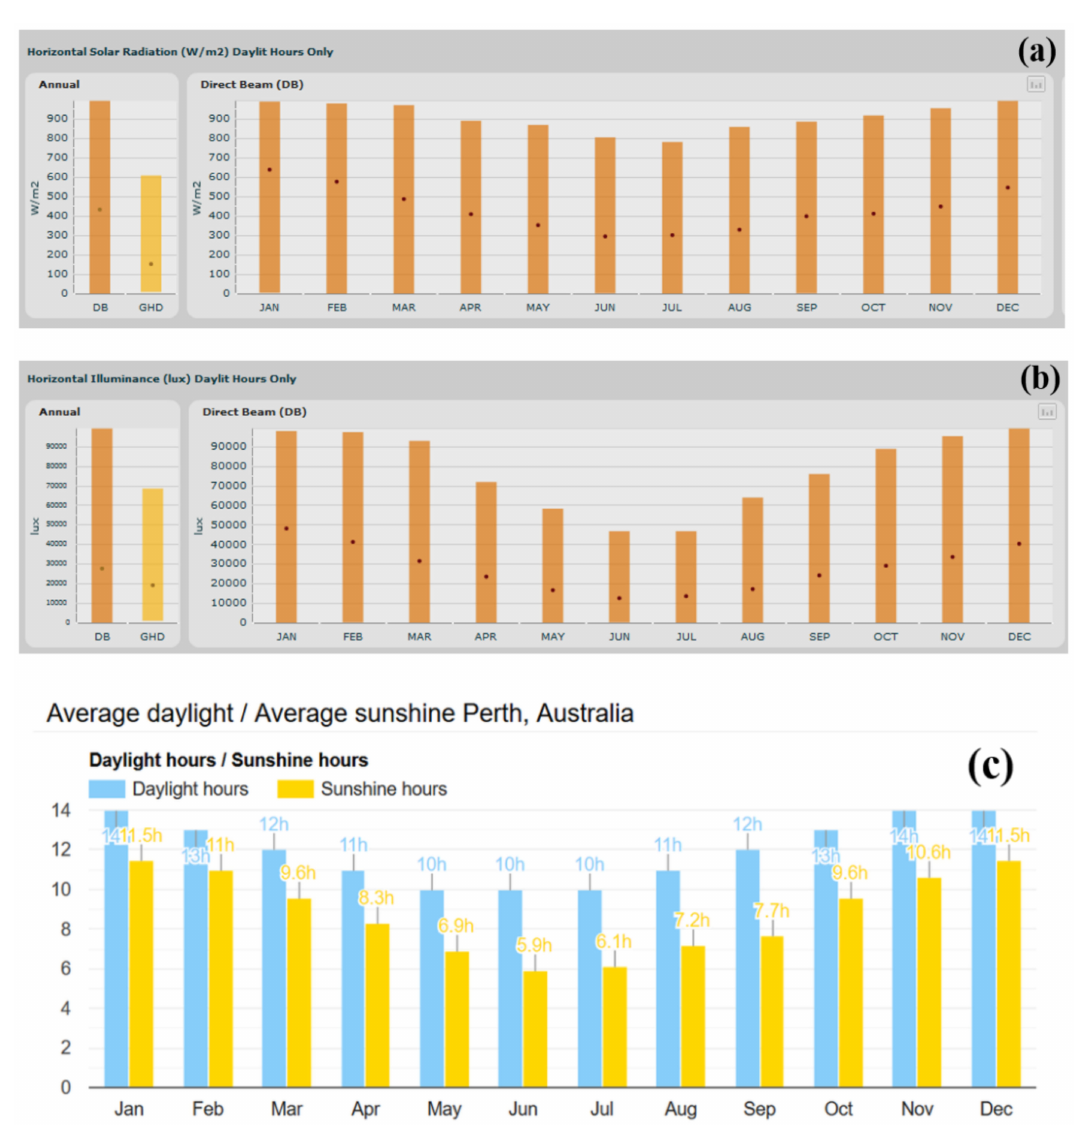
Figure 7. Seasonal yearly climate-related solar irradiation parameter variations for Perth, Australia. ( a ) Monthly averaged and maximum-recorded direct-beam solar irradiation intensities measured across horizontal plane; ( b ) monthly averaged and maximum-recorded direct-beam solar illuminance values measured across horizontal plane; ( c ) monthly distributions of the total daylight hours and the daily sunshine durations. The datasets shown in parts ( a ) and ( b ) have been obtained using COMFEN 5 software [46]; the dataset of part ( c ) has been published online by [31], using the publicly-available Australian Bureau of Meteorology